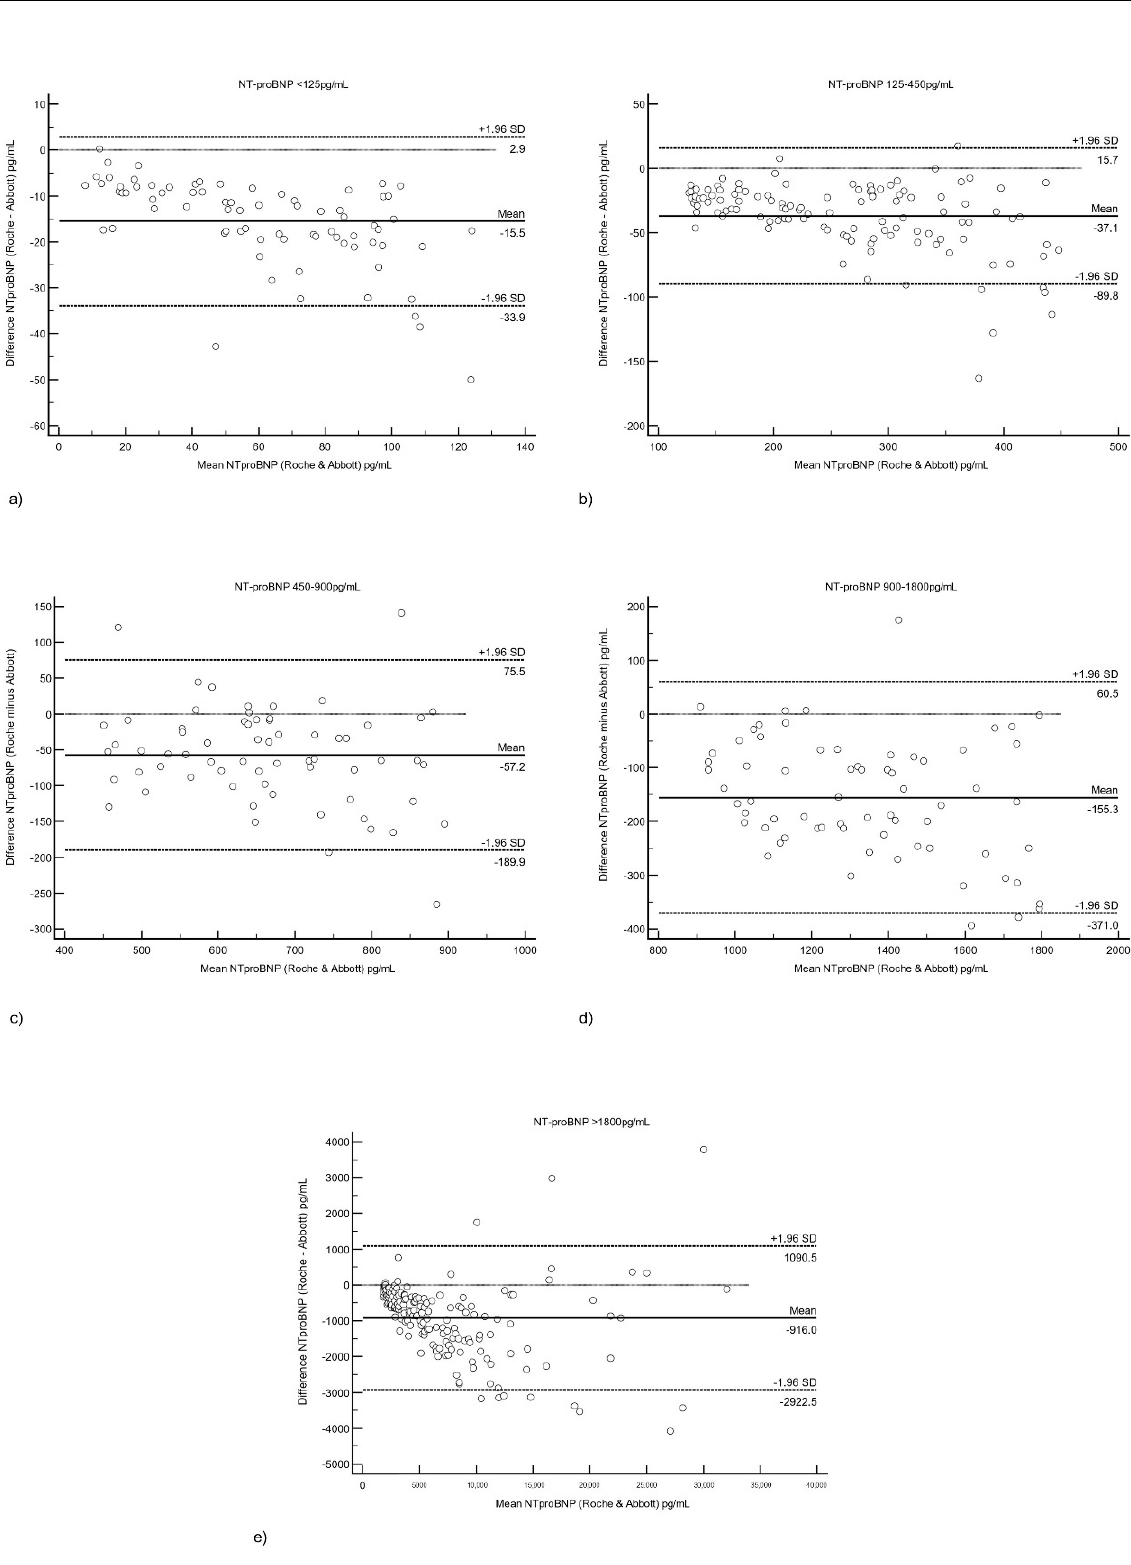
Figure 2. Bland–Altman analysis of the bias between the Roche and Abbott NT-proBNP assays at diagnostic cut-offs of Roche NT-proBNP. ( a ) <125 pg/mL and ( b ) 125–450 pg/mL, and according to ESC/AHA age-related cut-offs of ( c ) 450–900 pg/mL, ( d ) 900–1800 pg/mL, ( e ) >1800 pg/mL. Abbreviations: NT-proBNP: N-terminal pro-brain natriuretic peptide.